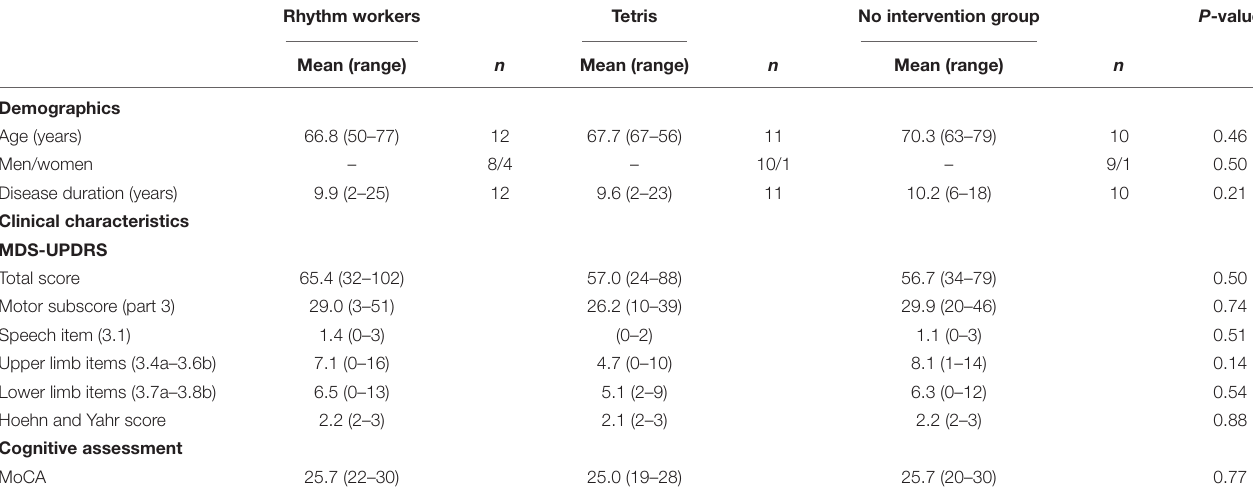
TABLE 1 | Patients’ demographic and clinical characteristics. Rhythm workers Tetris No intervention group P